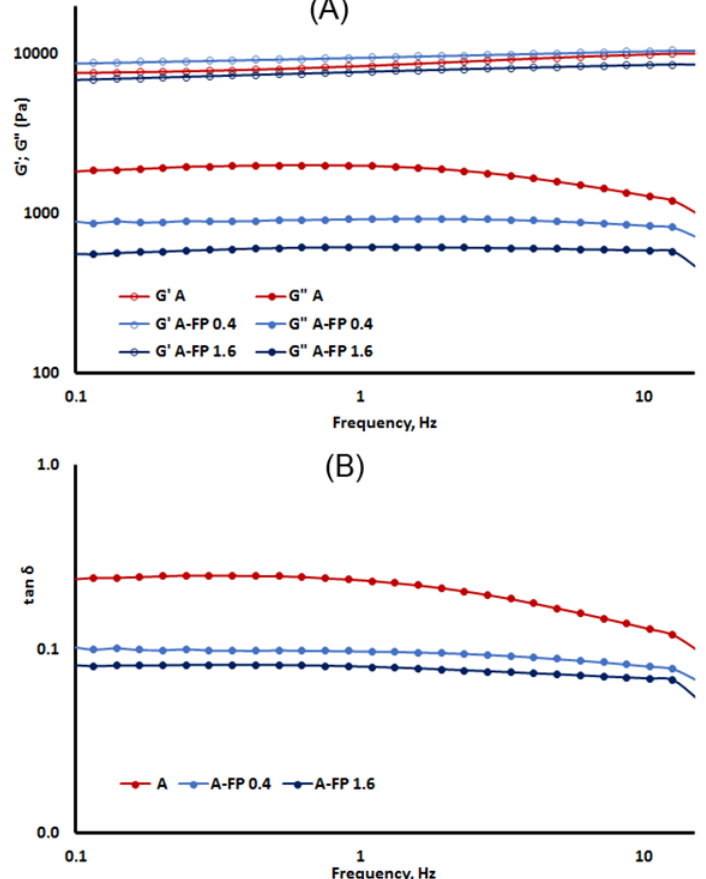
Figure 3. Storage modulus (G’, void symbols) and loss modulus (G”, filled symbols) test ( A ) and tan δ test results ( B ) represented as a function of frequency.